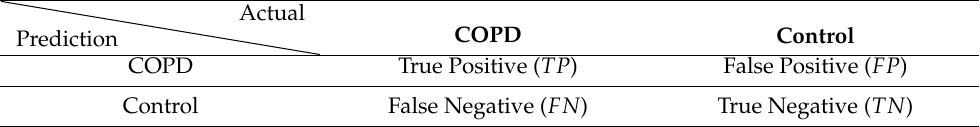
Table 1. Confusion